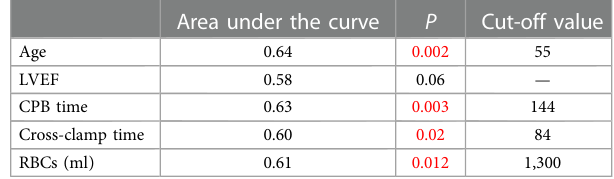
TABLE 4 Details of the ROC curve